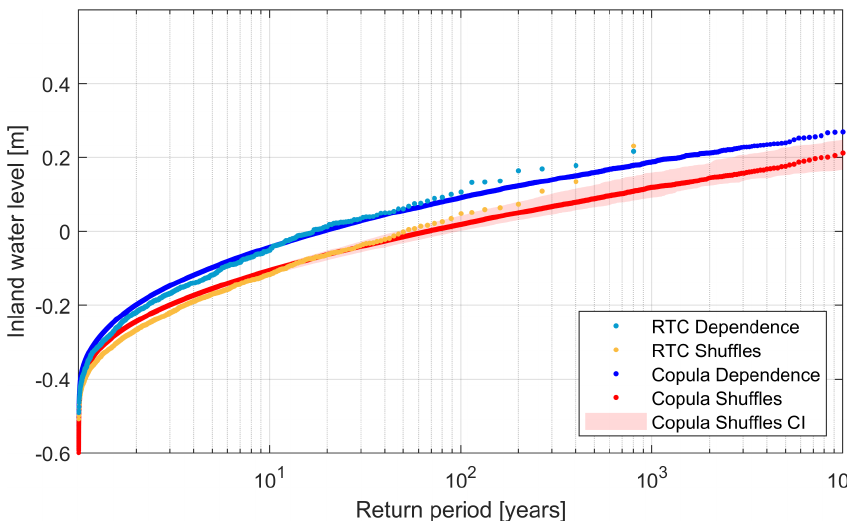
Figure 8. IWL return level against estimated return period using a bivariate copula model (2D case). Blue and red dotted lines depict the dependence and independence cases, respectively. Transparent red denotes confidence intervals, which account for the uncertainty range between the 5th and 95th percentiles, as computed from all shuffles. Light blue dots and orange dots represent the return values empirically obtained by van den Hurk et al. (2015). Table 4. Settings used in subpanels of Figs. 9 and 10 to assess climate variability (green). 50-year runs 800-year ensemble Subpanels Impact function Copula SWL PDF Precipitation PDF Impact function Copula SWL PDF Precipitation PDF a x x x